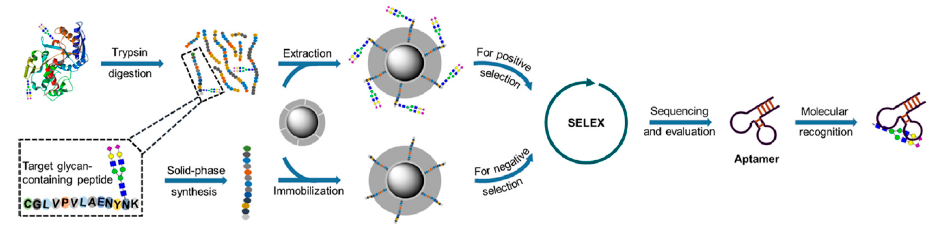
Figure 17. Principle of SELEX selection of glycan-binding aptamers on peptide-imprinted MNPs. Reprinted from ref. [198]. Copyright (2021) with permission from American Chemical Society.